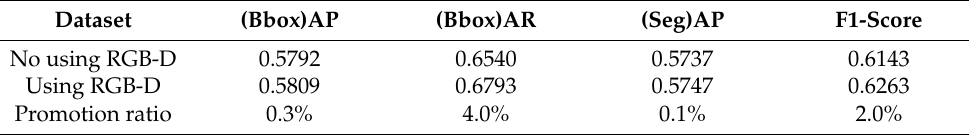
Table 3. Validity analysis of RGB-D image.